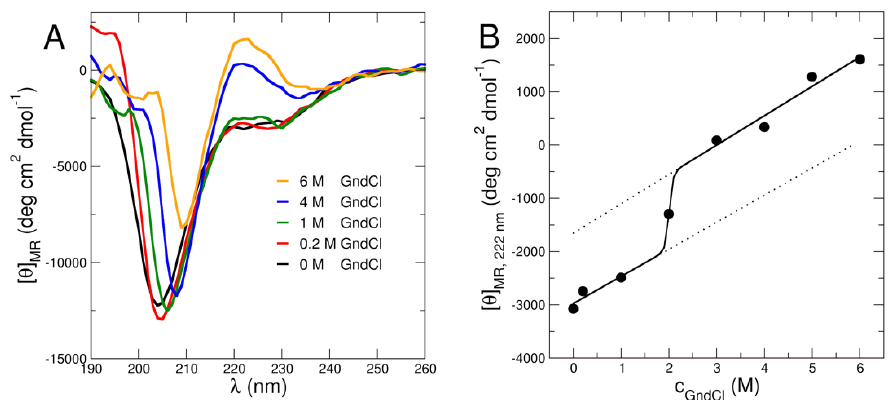
Figure 1. ( A ) CD signal at different GndCl concentrations demonstrating the largely disordered nature of MBP under all investigated solvent conditions. The emerging peak between around 220 and 230 nm is indicative of polyproline type II helix formation with accompanied structural expansion of MBP. ( B ) CD intensity at a wavelength of 222 nm as function of c GndCl reporting on structural expansion of MBP. Symbols show experimental CD data, the solid line indicates an empirical sigmoidal fit and the dotted lines show pre- and post-transitional sloping behavior.